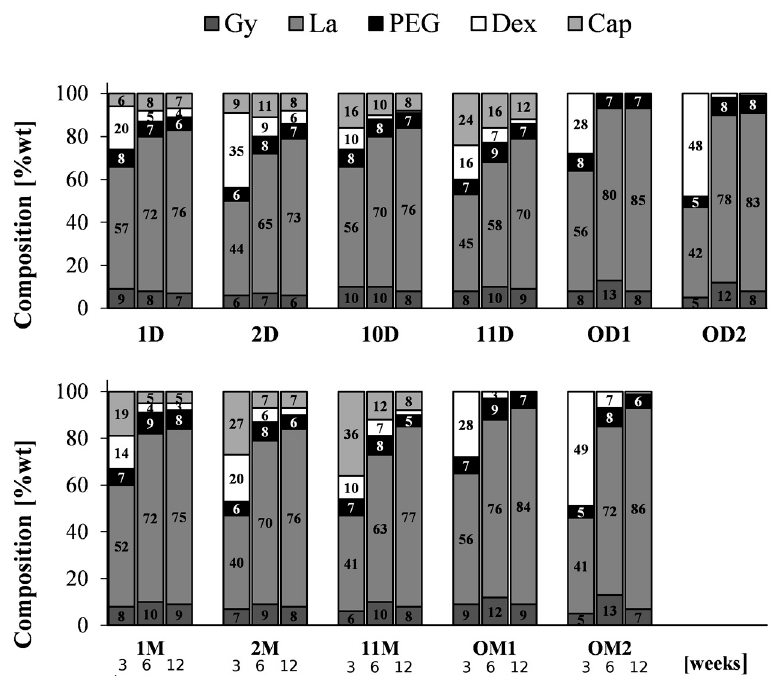
Figure 6. Changes of the blends composition during degradation process conducted in soil (wt.%) (estimated based on 1H NMR measurement).